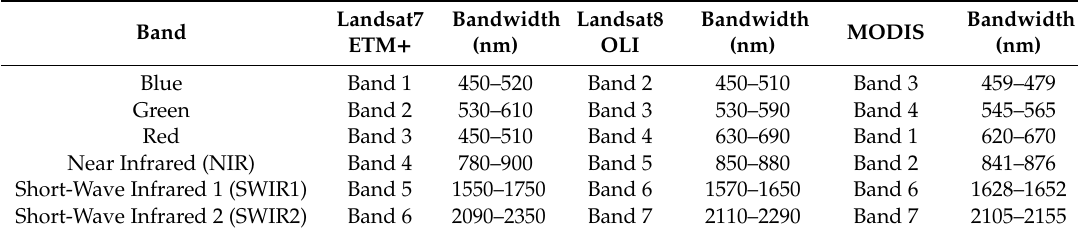
Table 1. Information of corresponding bands of Landsat7 ETM + , Landsat8 OLI, and MODIS.